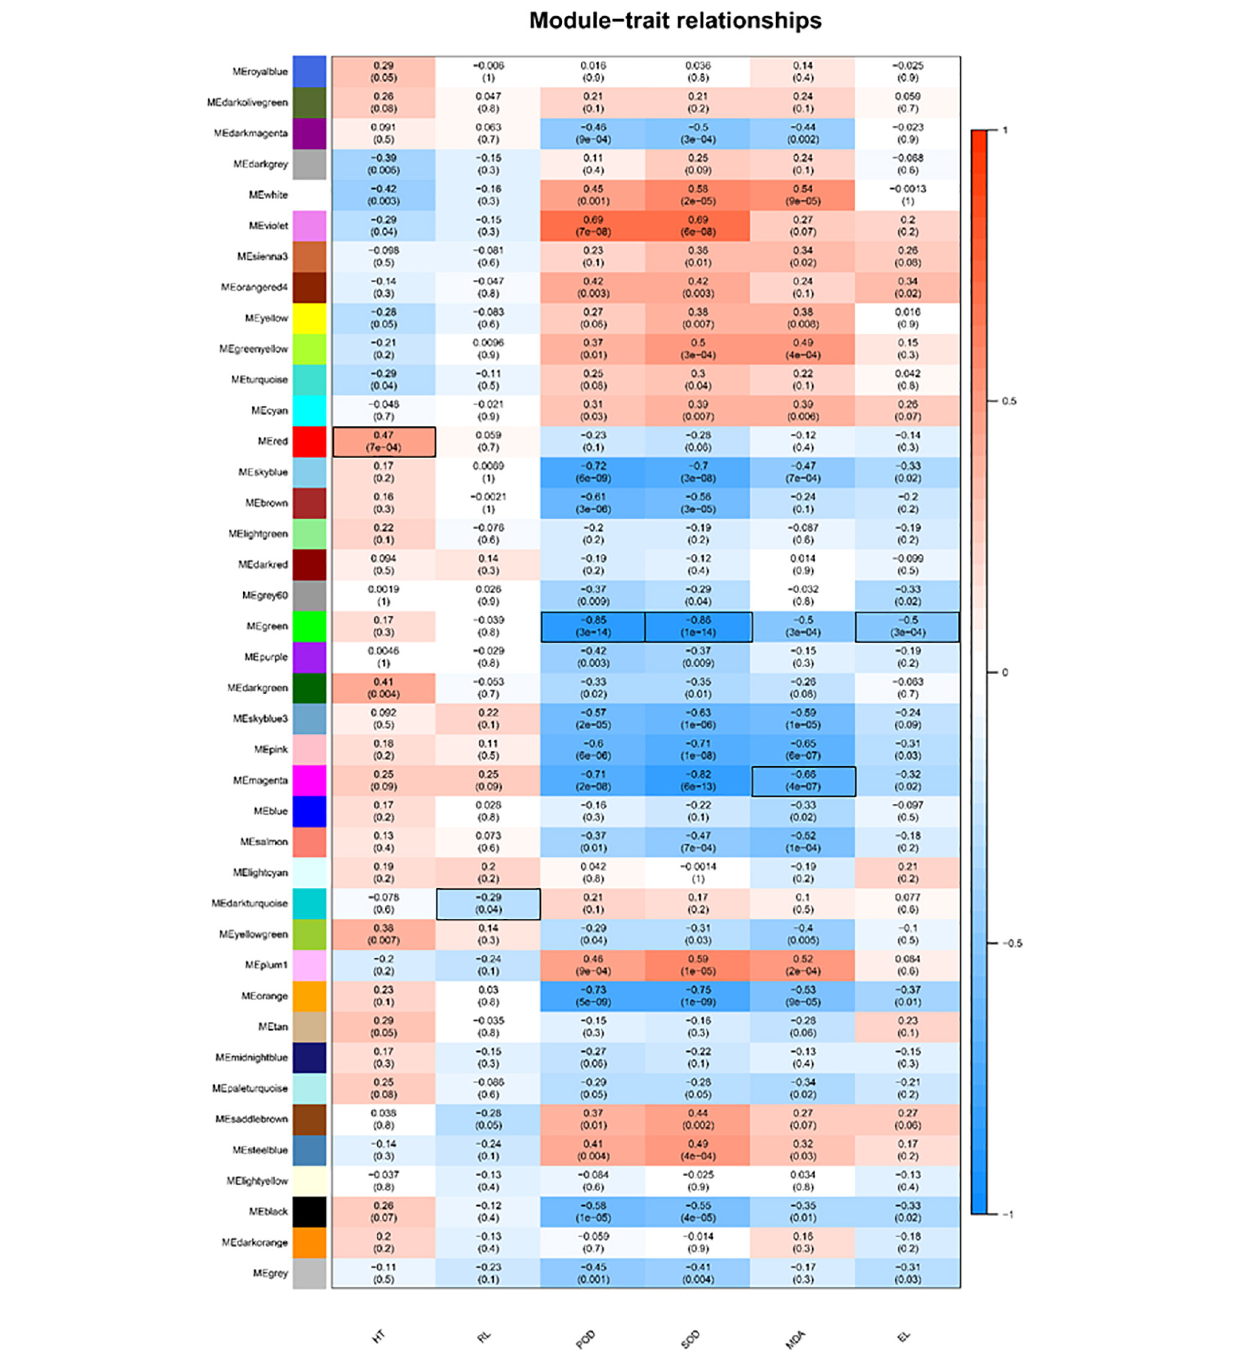
FIGURE 2 | Gene expression modules correlated with quantitative trait of C. dactylon phenotype and physiology, including plant height (HT), root length (RL), peroxidase (POD), superoxide dismutase (SOD), malondialdehyde (MDA), and electrical conductivity (EL). We report the Pearson coefficient and its p -value. Highly positive correlations are shown in dark blue and highly negative correlations are shown in dark red. The combination of module-trait marked in black frame will be selected for subsequent annotation